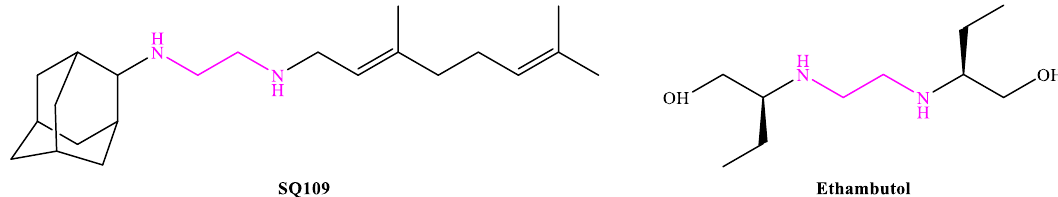
Figure 2. Chemical structures of SQ109 and ethambutol.